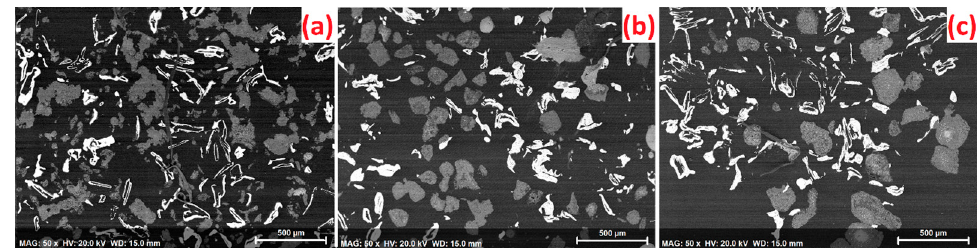
Figure 12. Backscattered electron micrographs of the reduced products resulted from the ore samples with particle size ranges of ( a ) 37–75 µm, ( b ) 105–180 µm, and ( c ) 180–300 µm.